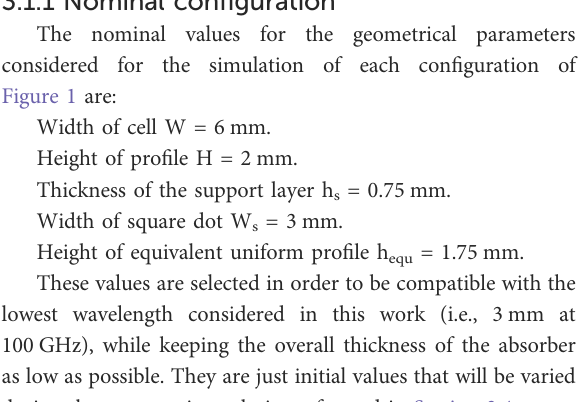
Figure 1 are: Width of cell W = 6 mm. Height of pro fi le H = 2 mm. Thickness of the support layer h s = 0.75 mm. Width of square dot W s = 3 mm. Height of equivalent uniform pro fi le h equ = 1.75